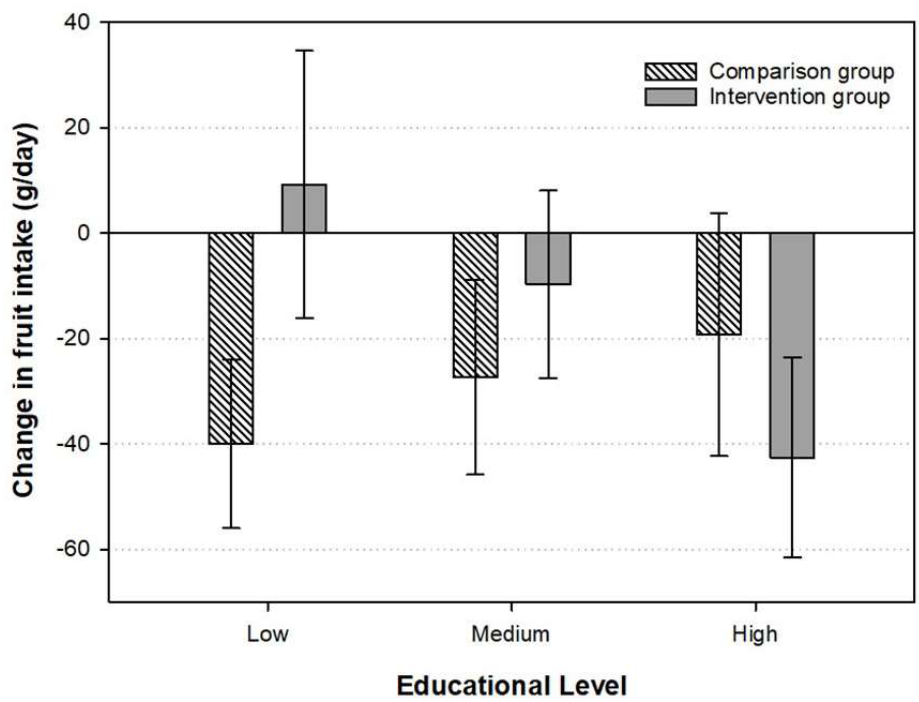
Figure 1. Intake of fruit in intervention/comparison groups by maternal education level. Intervention group (low education n = 46, medium education n = 64 and high education n = 74). Comparison group (low education n = 42, medium education n = 50 and high education n = 30). Adjusted for age and sex.